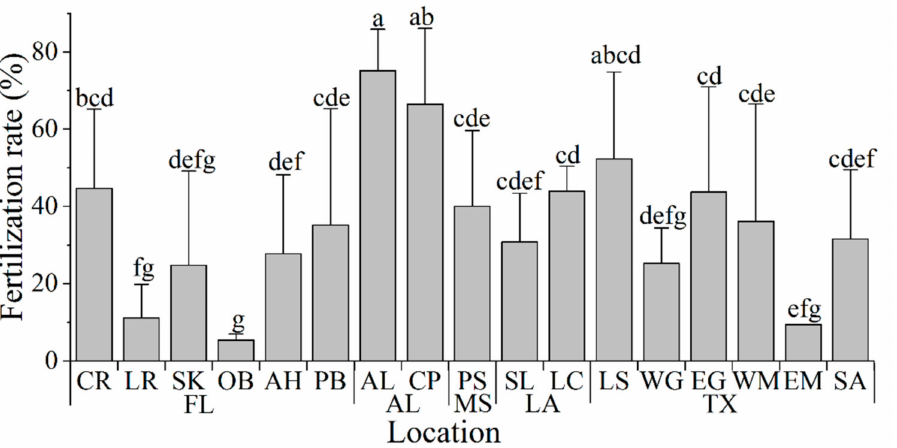
Figure 5. Fertilization rate (%) observed using fresh sperm of Eastern oysters Crassostrea virginica ( n = 6, each male was used to cross two females) from different collection sites in the Gulf of Mexico. Groups labeled with the same letters (a–f) are not statistically different ( p >